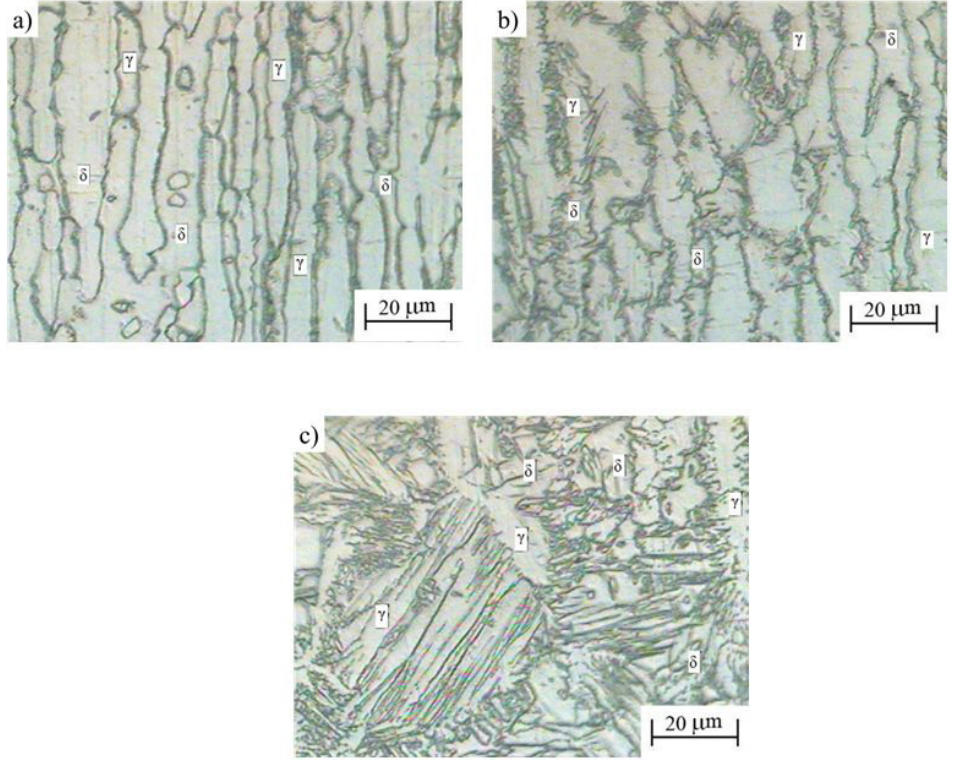
Figure 5. Microstructure of WJ2 treated 15 minutes at 800°C. Images for (a) BM, (b) FL and (c) WMC regions. Reagent: Behara.